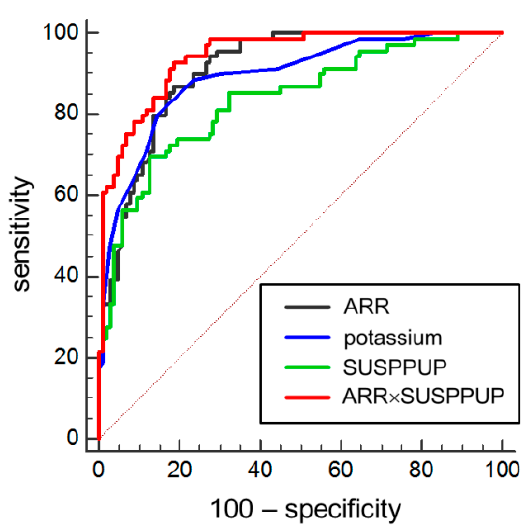
Figure 1. Receiver operating curve analysis for sensitivity and specificity of thresholds for serum potassium (K S , blue), the serum sodium to urinary sodium divided by (serum potassium) 2 to urinary potassium (SUSPPUP) ratio (green), the aldosterone to renin ratio (ARR, black) and the product of both (red) to diagnose primary aldosteronism. Red dot line is line of equality or random chance.